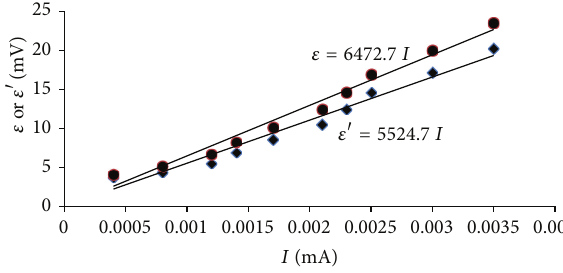
Figure 7: Plot of 𝐼 versus 𝜀 values for obtaining polarization resistance, 𝑅 𝑝 and 𝑅 󸀠 𝑝 . Table 1: Sample calculation for 𝑅 .